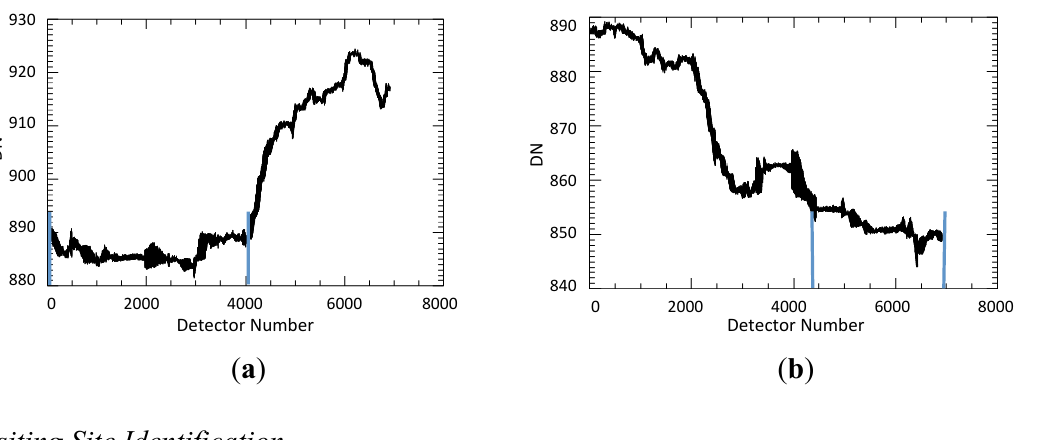
Figure 13. Column averages of calibrated side slither data resulting from maneuvers of ( a ) 89 degrees and ( b ) 91 degrees